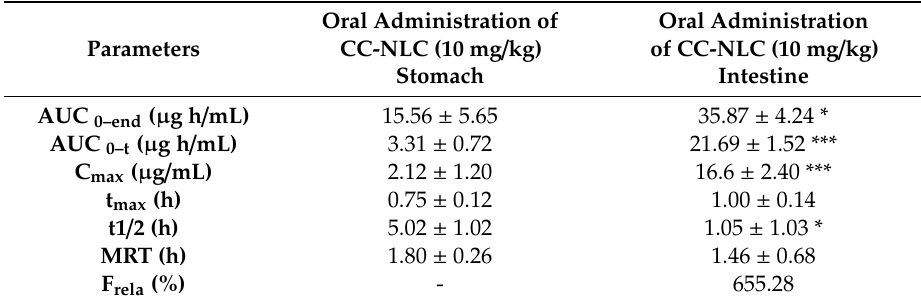
Table 3. Pharmacokinetic parameters of CC in rats following the absorption of CC-NLC from the stomach and intestine at a dose of 10 mg / kg.